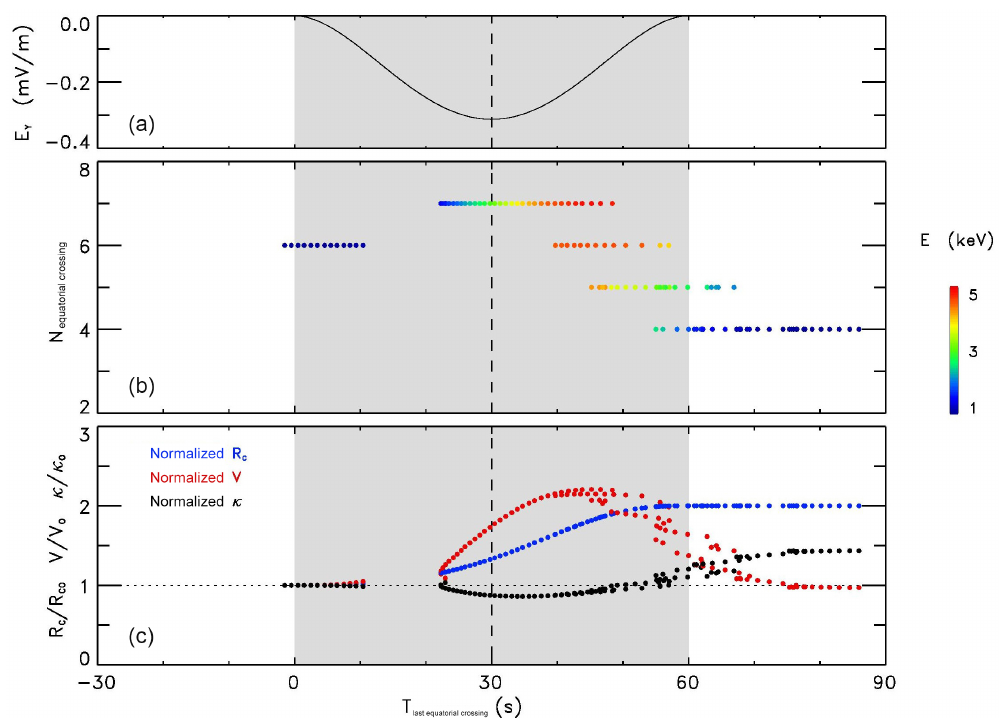
Figure 4. From top to bottom: electric field magnitude, number of equatorial crossings, and final value of κ (normalized to the initial one; coded in black) as a function of last equatorial crossing time. The bottom panel also shows the final values of field line curvature radius and particle speed (coded in blue and red, respectively), normalized to their initial values. In the middle panel, the final H + energy is coded according to the color scale on the